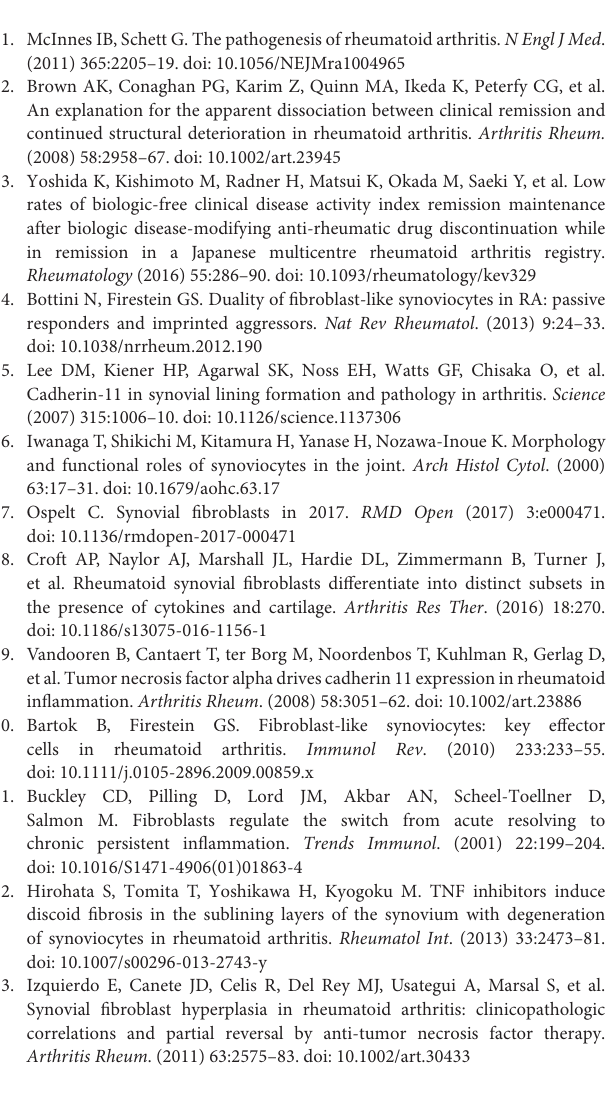
Supplemental Figure 1 | The quantitative data show the cell density of pPDGFR αβ + CDH11 − , pPDGFR αβ − CDH11 + , and pPDGFR αβ + CDH11 + cells. The cell densities of pPDGFR αβ + CDH11 − , pPDGFR αβ − CDH11 + , and pPDGFR αβ + CDH11 + cells in the LL were not different between RA and control (pPDGFR αβ + CDH11 − , pPDGFR αβ − CDH11 + , pPDGFR αβ + CDH11 + cells) in the SL of the synovium. One-way ANOVA was used for statistical analysis. The significance level was P < 0.05.